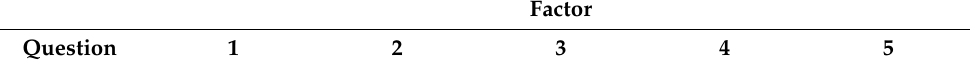
Table 6. Factor load